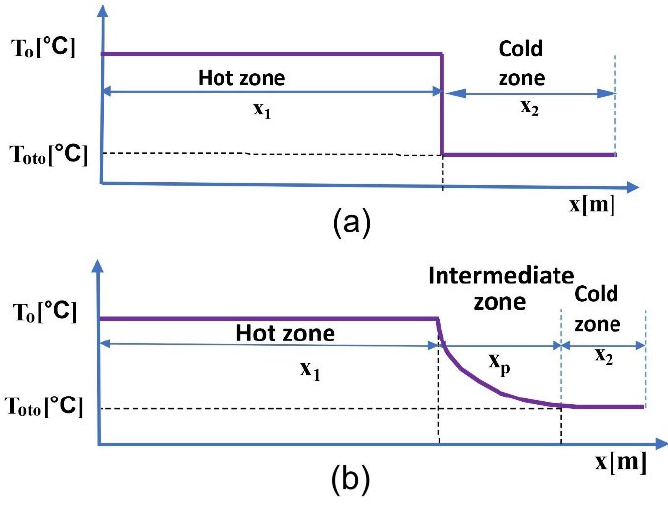
Figure 8. Cable division into thermal zones: ( a ) commonly used for the computations, ( b ) actual. T oto is a cable ambient temperature, T 0 is an impact temperature of an external temperature field, x 1 is the length of the hot zone, x 2 is the length of the cold zone, and x p is the length of the intermediate zone. It should be noted that the intermediate zone occurs in both directions from the heat source along the cable’s longitudinal axis. The experiments conducted within this study assumed and involved executing temperature measurements in one direction along the cable.